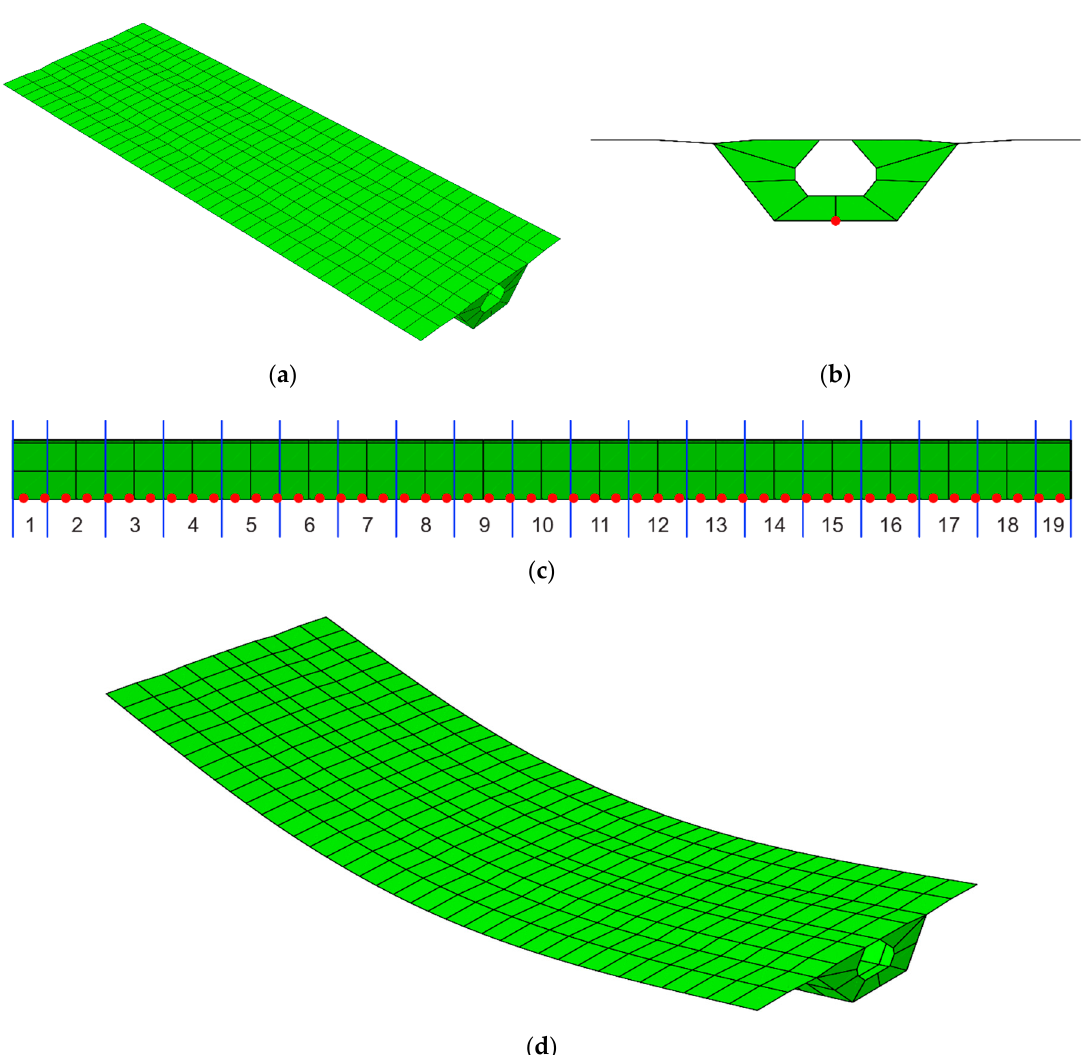
Figure 5. Numerical application: ( a ) shape of the bridge structure, ( b ) layout of the strain sensors, ( c ) segments of the structure, and ( d ) first mode shape of the